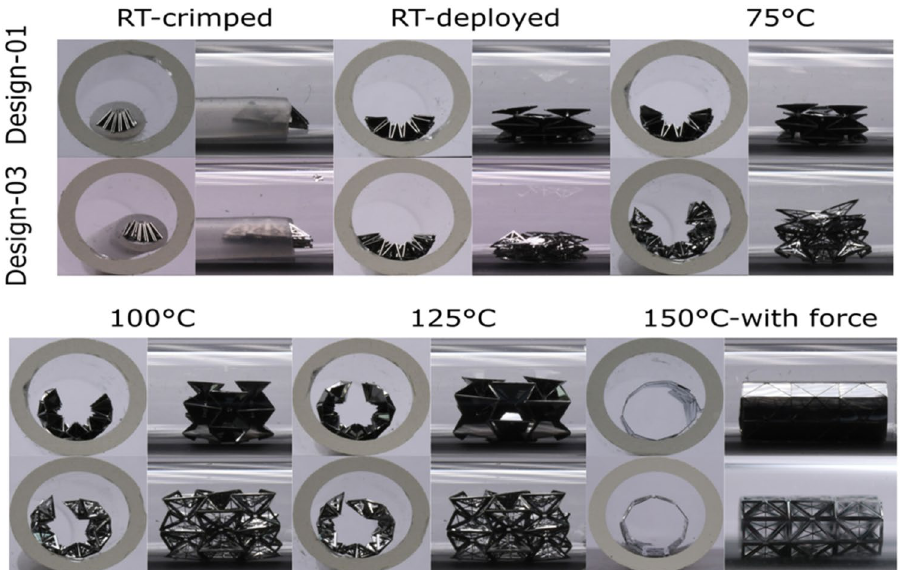
Figure 4. Profile pictures of the stent-devices expanded in a glass tube (Ø 6.3 mm) on heating. Two images (cross-sectional and front view) for each temperature are acquired for designs 1 & 3. The room temperature (RT) images show that the devices are crimped in a catheter of an internal diameter of 2 mm. On heating to 150 °C, the devices did not recover their shape entirely, and a force from the inside was required for complete shape regain. The image is made using Inkscape (V 0.92, https:// inksc ape.